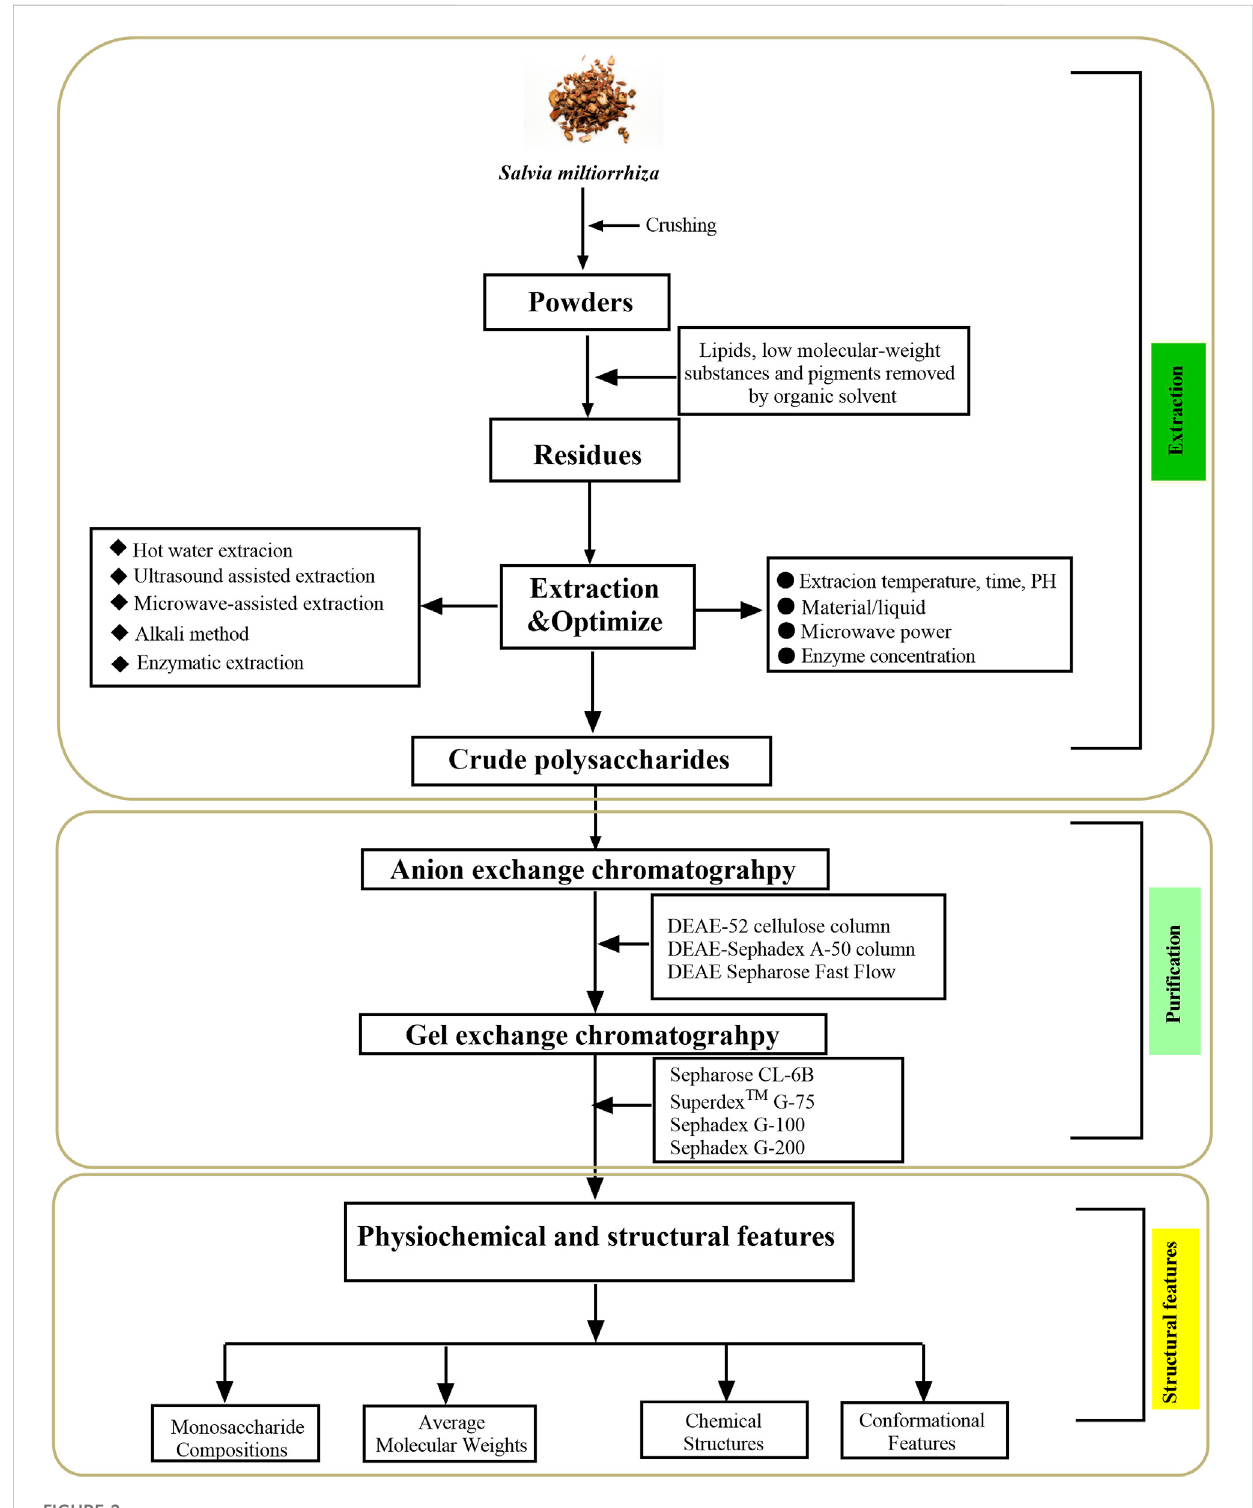
The fl owchart of the extraction, puri fi cation, and structural features of Salvia miltiorrhiza